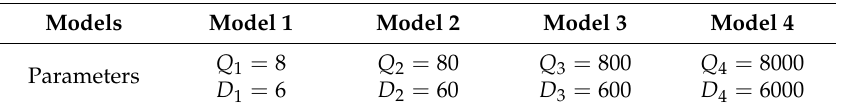
Table 2. Q i and D i for different models.